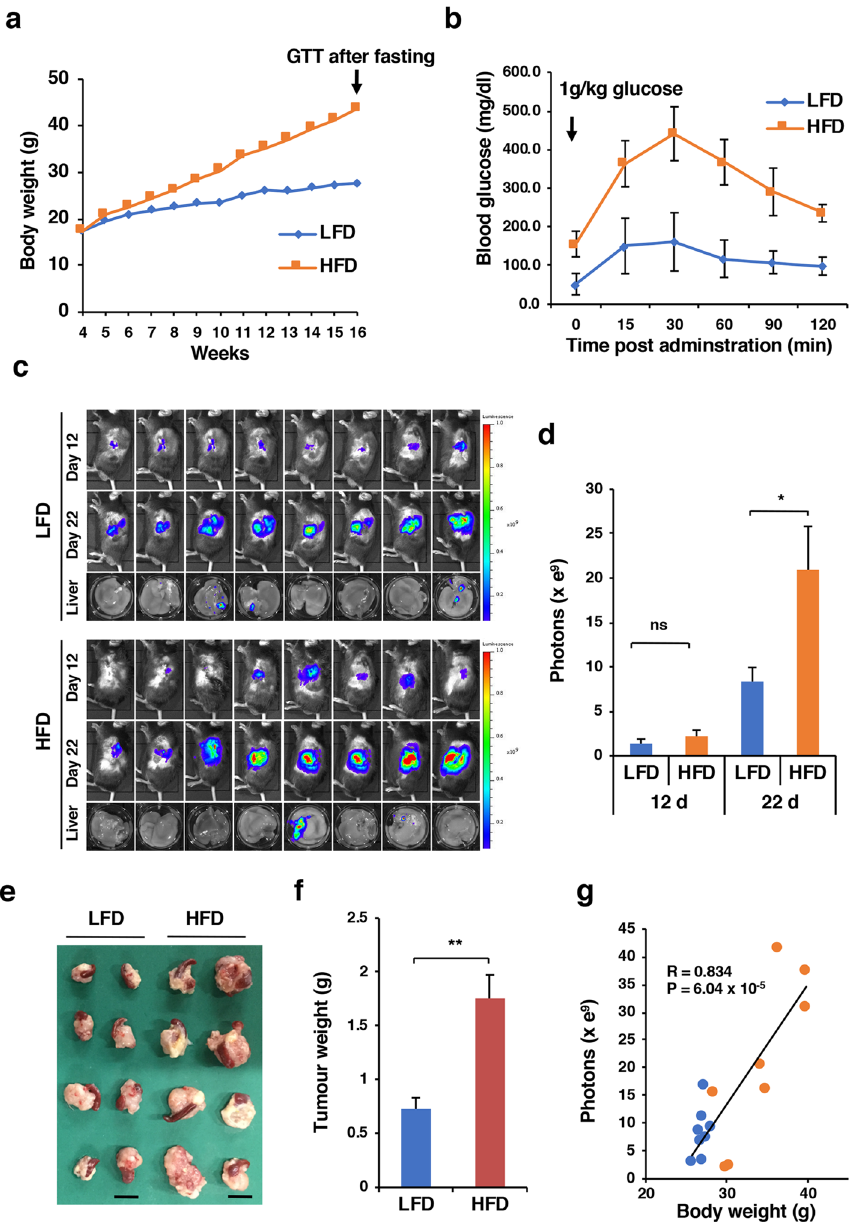
Figure 1. Orthotopic tumour growth of Panc02-Luc-ZsGreen cells in DIO mice. ( A ) Body weight. Four-week- old male C57BL/6J mice were fed either an LFD or an HFD (n = 11 mice for each group). After 16 weeks, a glucose tolerance test (GTT) was performed after overnight fasting. ( B ) GTT. The mice fed an LFD or an HFD (n = 5 mice for each group) were administered 1 g/kg glucose intraperitoneally for the GTT. ( C ) Orthotopic tumour growth and liver metastasis in the mice fed an LFD or an HFD (n = 8 mice for each group). On day 12 and day 22, the mice were subjected to in vivo bioluminescent imaging. ( D ) Tumour growth on day 12 and day 22 represented by photons. Photons from animals’ whole bodies were imaged using the IVIS imaging system. ( E ) Orthotopic tumours with the spleen resected from the mice fed an LFD or an HFD on day 22. Bars 1 cm. ( F ) Tumour weight. ( G ) Correlation between body weight and tumour size (photons). Blue and orange circles represent individual mice in the LFD and HFD groups, respectively. *P < 0.05, **P < 0.01, ns, not